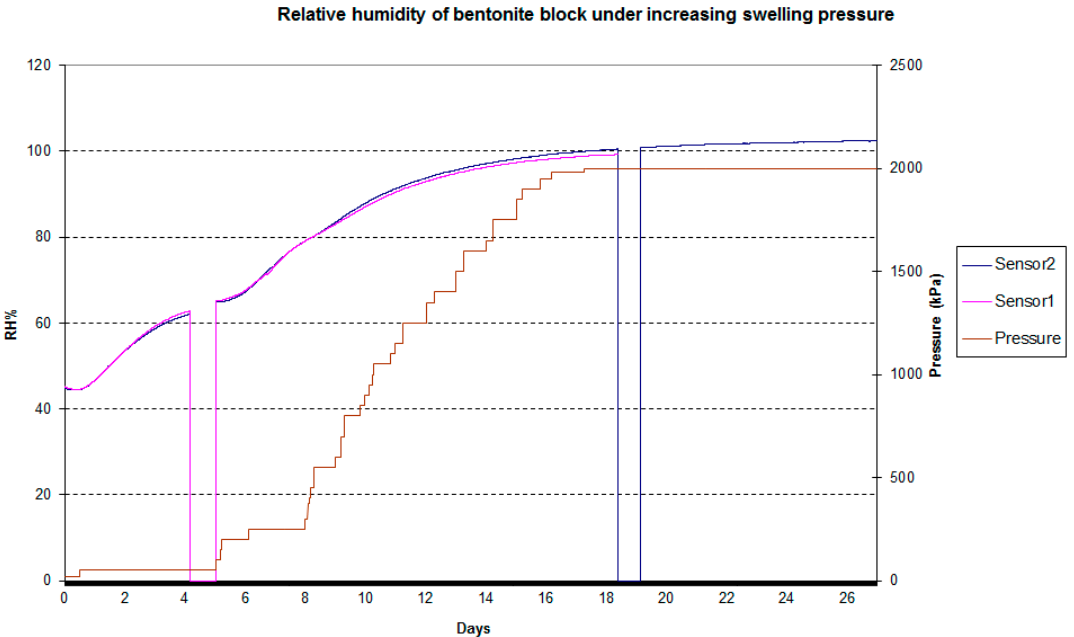
Figure 7. Evolution of relative humidity and water pressure during the hydration of the bentonite within the oedometer cell.